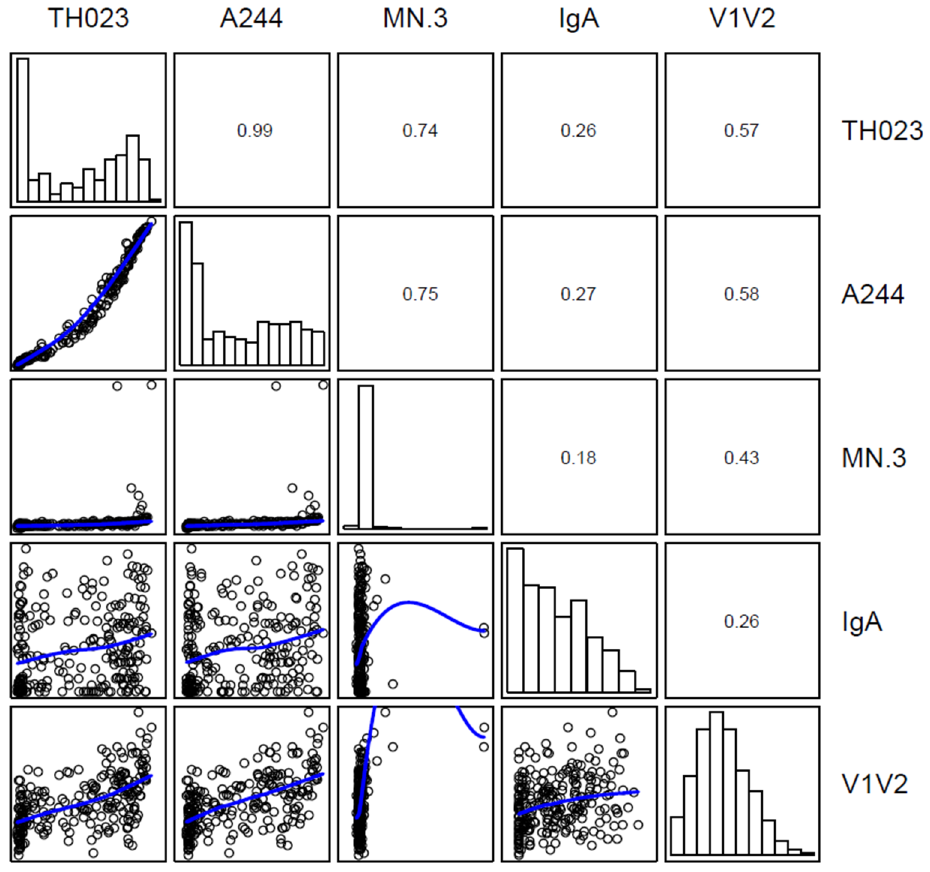
Fig 5. Correlation between RV144 case-control readouts for three V1V2-specific complement activating antibody specificities (92TH023,A244, MN) and primary IgA and IgG V1V2 readouts. The log-transformed MFI or OD values are displayedin pairwisescatter plots below the diagonal or as a histogram on the diagonal. For each pair of readoutsthe Spearmancorrelation is displayedabove the diagonal.Scatter plots includea blue loess smooth line. The primary IgA and IgG V1V2 primary variables were studiedin the originalcase-control